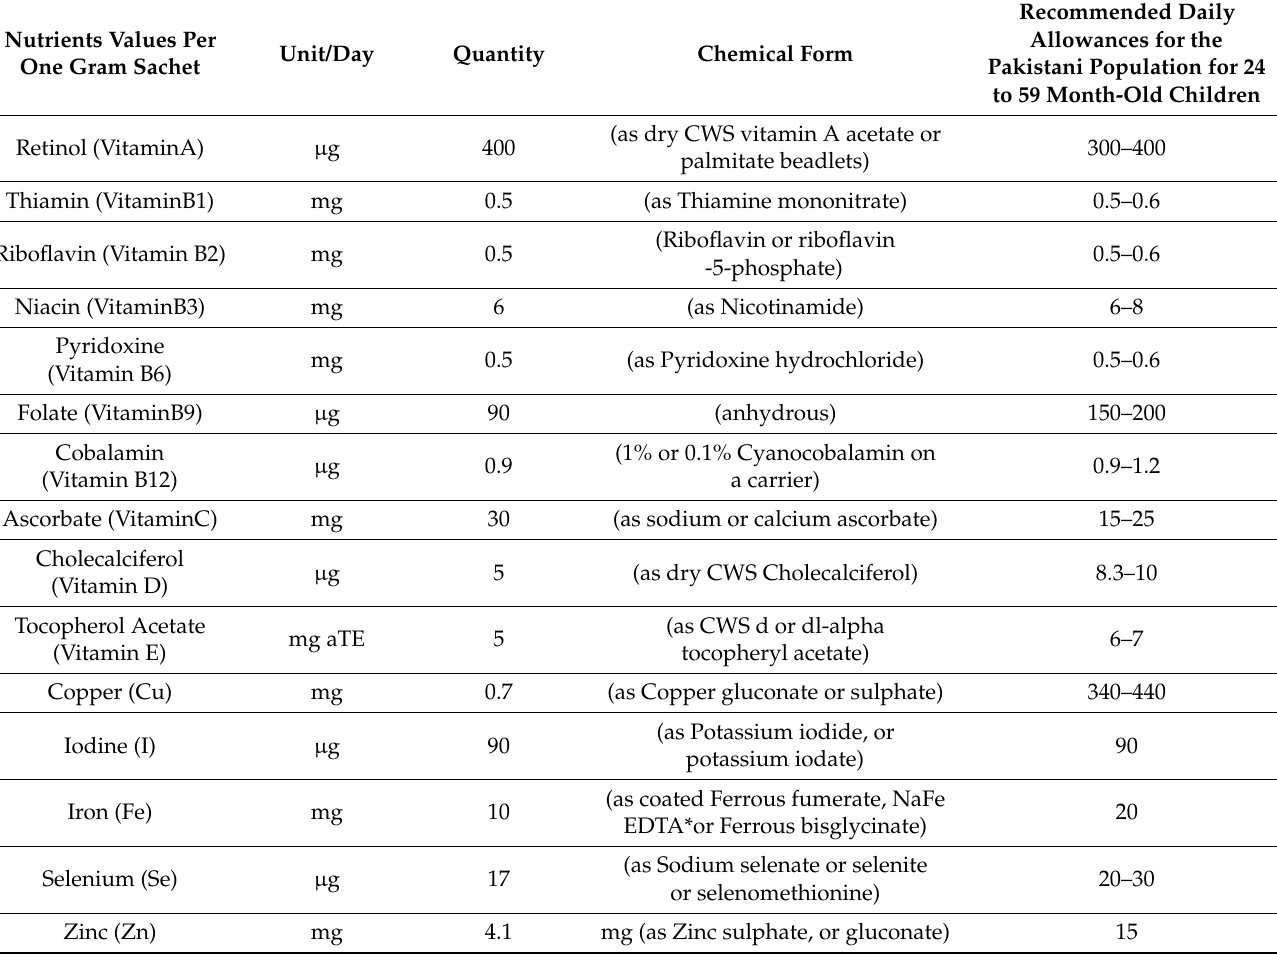
Table 1. Composition Multiple Micronutrient Powder